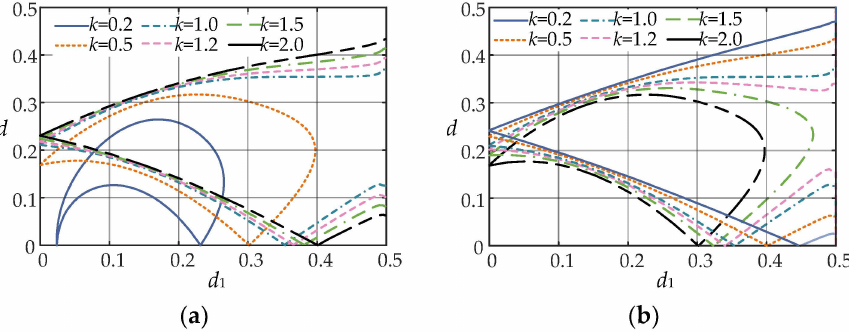
Figure 8. Design regions of no backflow power operation with DPS modulation scheme: ( a ) for H 1 ; ( b ) for H 2